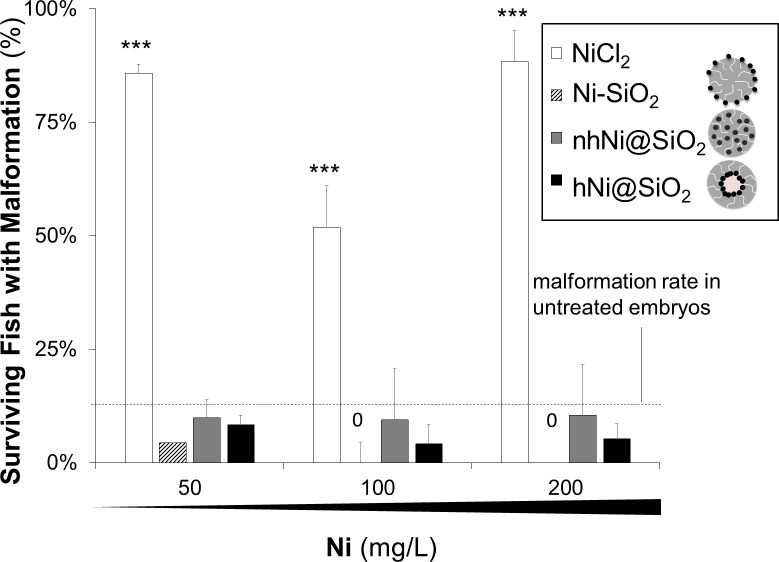
Malformations observed in surviving zebrafish larvae for NiCl2 and CENs on 5dpf.Malformation rate for unexposed control zebrafish larvae was 2.5% (indicated by the dashed line). Note that no malformations were observed for Ni-SiO2 at higher concentrations. ***p≥0.001 for one way ANOVA followed by Dunnett’s t-test, error bars are SSE. No significant development of malformations after exposure to Ni/SiO2 CENs.